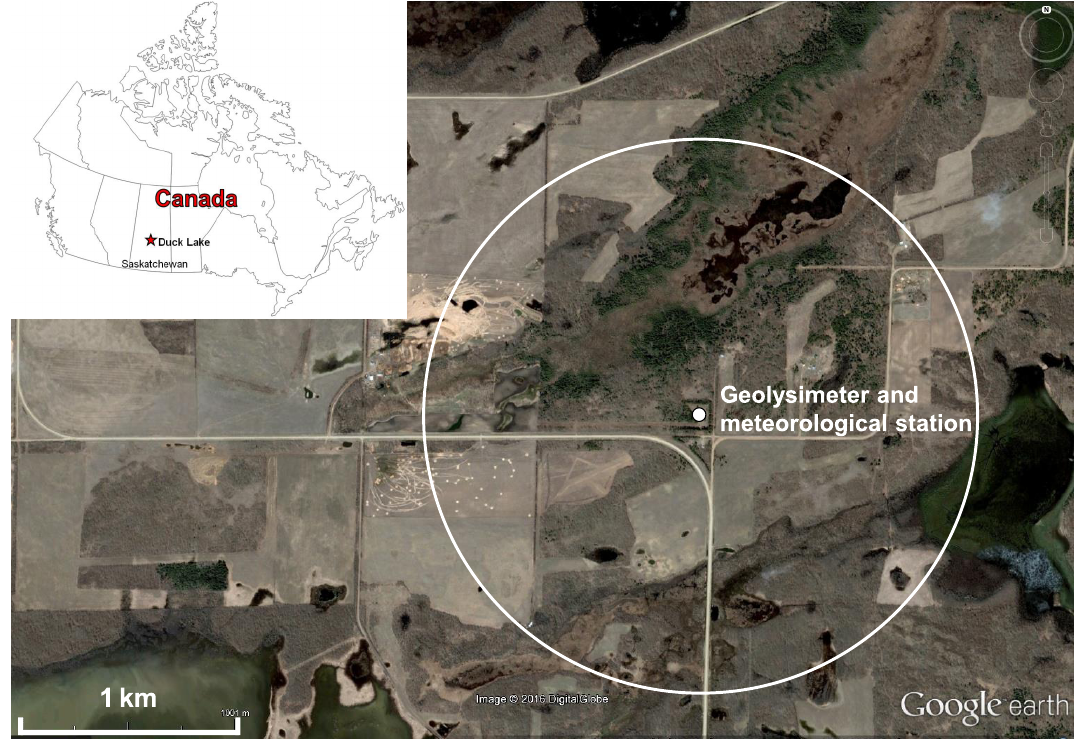
Figure 1. Location of the experimental site ∼ 10km north of Duck Lake, Saskatchewan, Canada (inset), and the location of Duck Lake No. 2 observation well and meteorological station centred in the geolysimeter response area, with a radius of ∼ 1.25km or 10 times the well depth (white